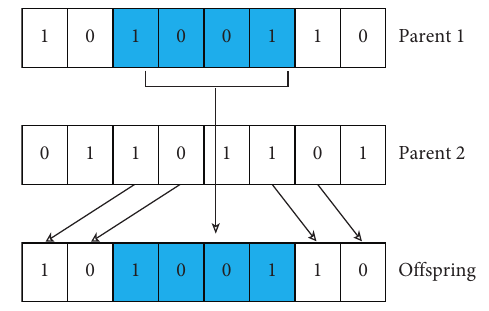
Figure 3: Two-point crossover.